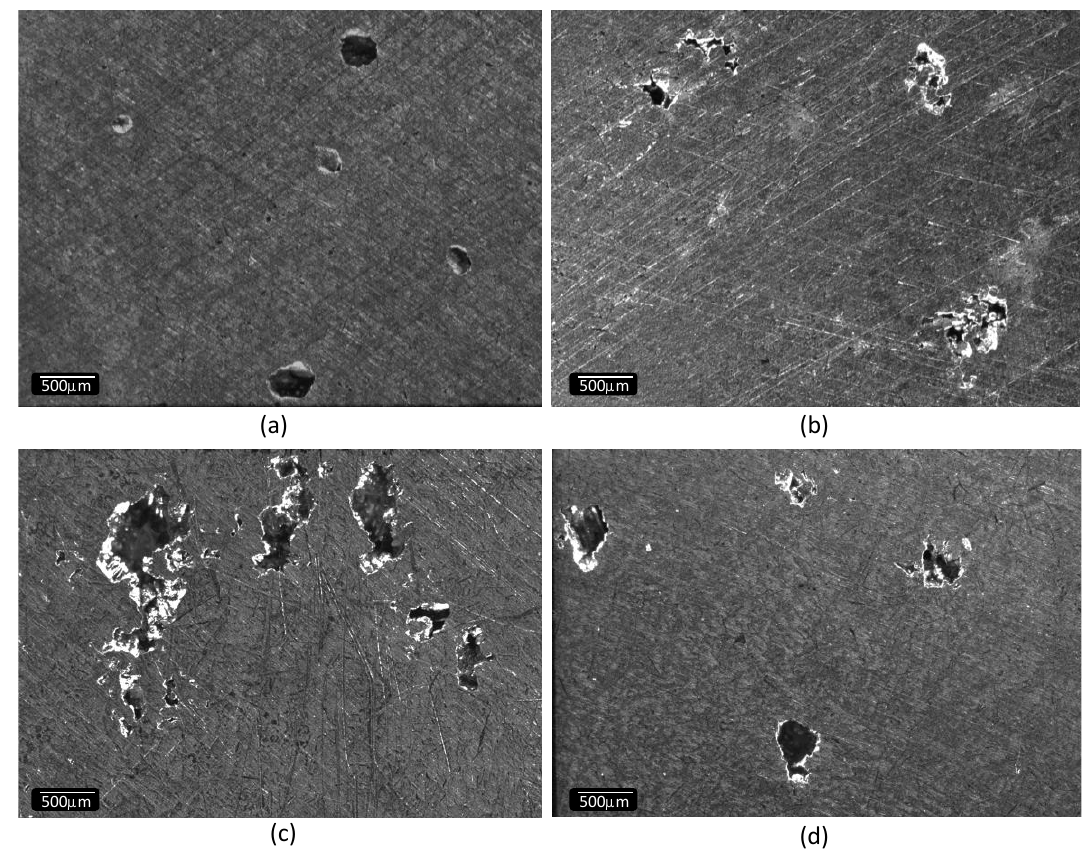
Figure 13 . Microstructure of defects: sand casting part ( a , b ); 3DP part ( c , d ). Figure 13. Microstructure of defects: sand casting part ( a , b ); 3DP part ( c , d